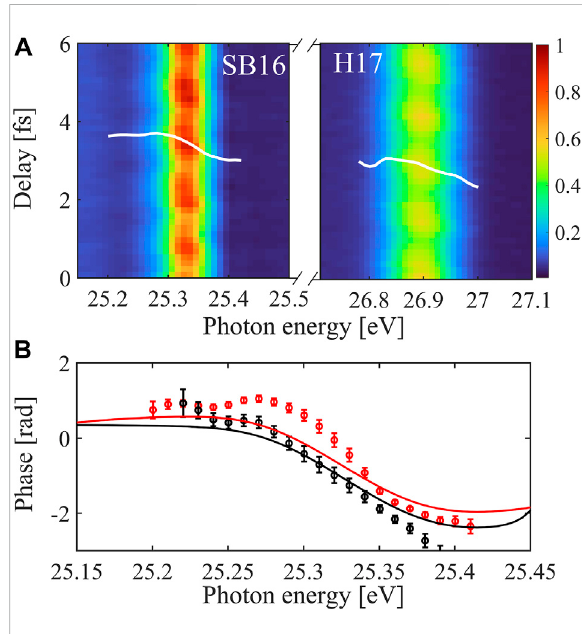
FIGURE 7 Angle-integrated measurements with the MBES. (A) Zoom-in on the oscillations of SB16 and H17. The extracted phase variation is indicated by the white lineouts. (B) Phase of SB16. Data points: phase measured with parallel (red) and perpendicular (black) XUV and IR polarizations; solid curves: calculated total phase for parallel XUV and IR polarizations (red) and d-wave only phase